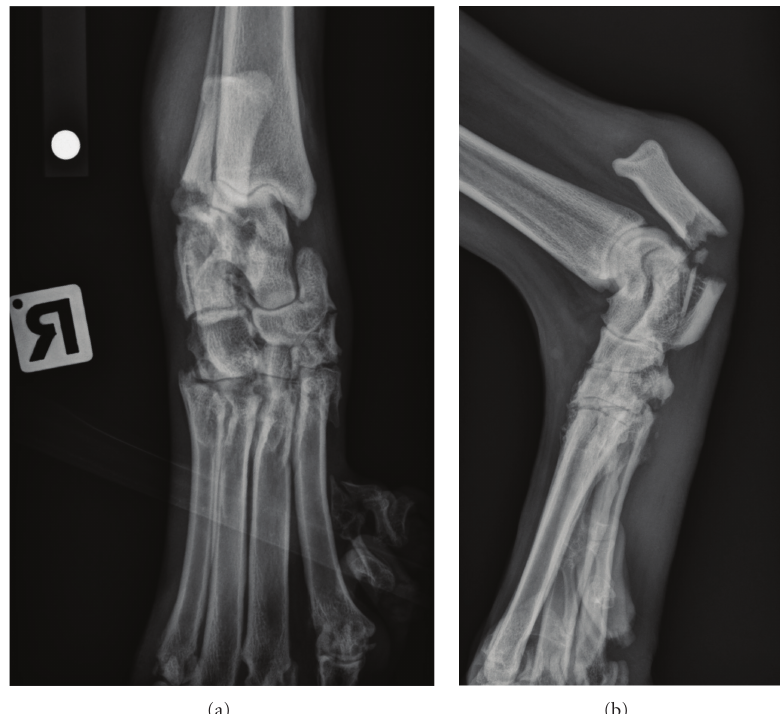
Figure 1: Preoperative dorsoplantar and lateral radiographs showing comminuted fracture of calcaneal body and distraction of calcaneal